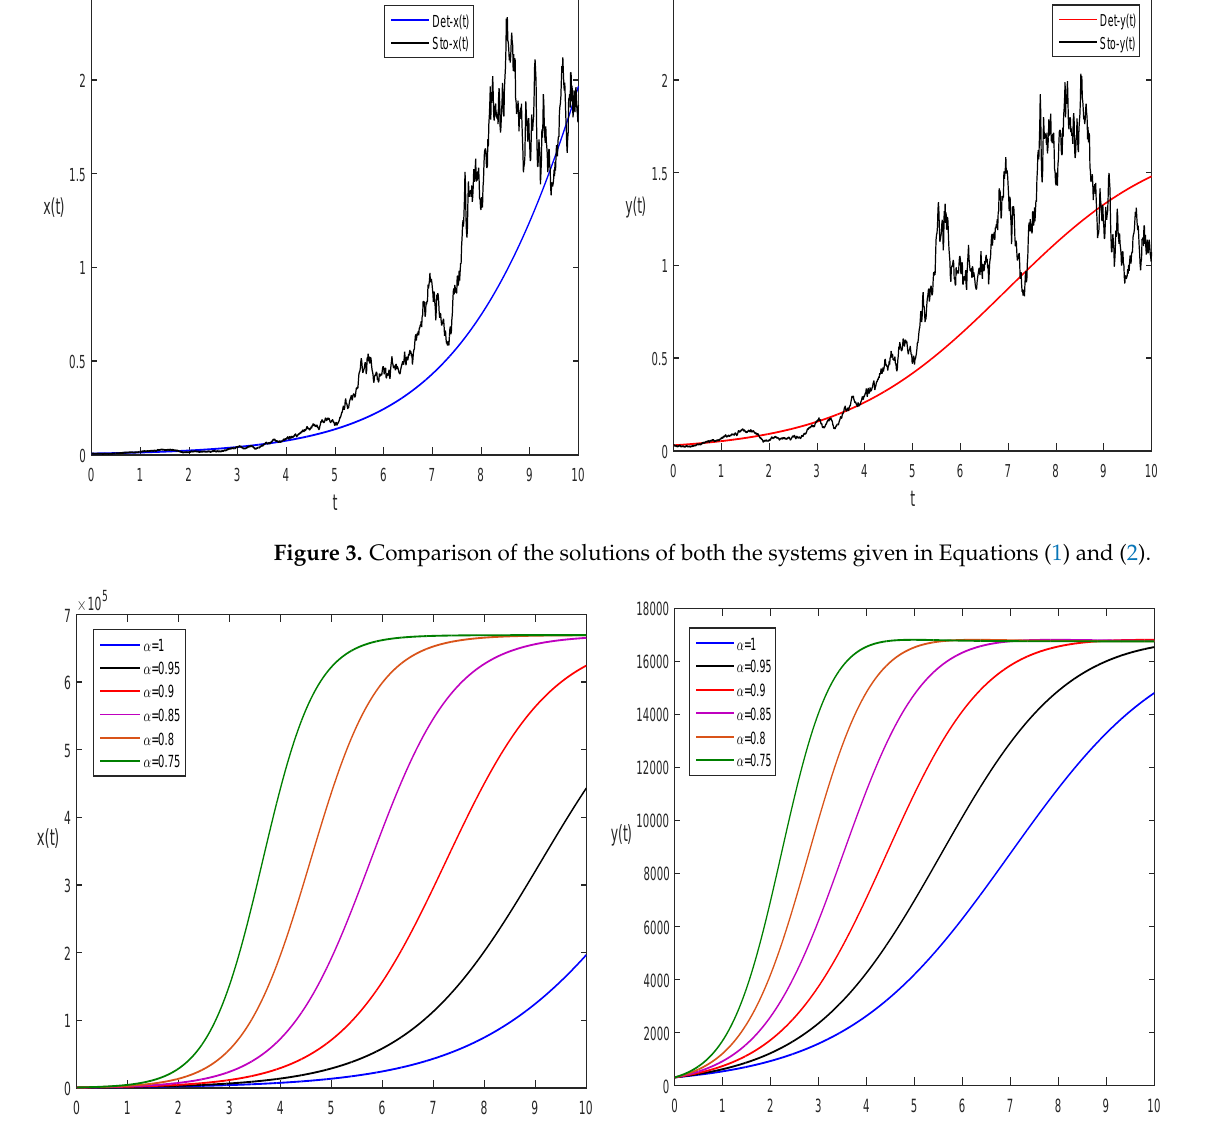
Figure 4. Simulation of deterministic fractional model in Equation (14) for different fractional parameter